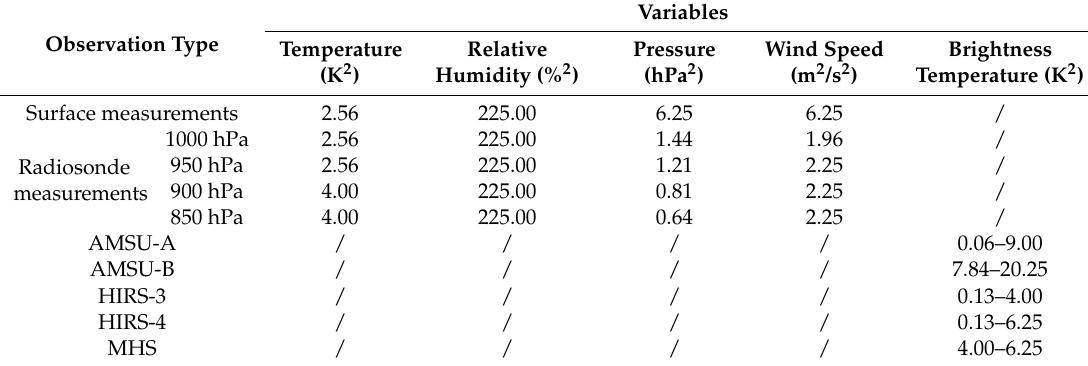
Table 3. Observation error